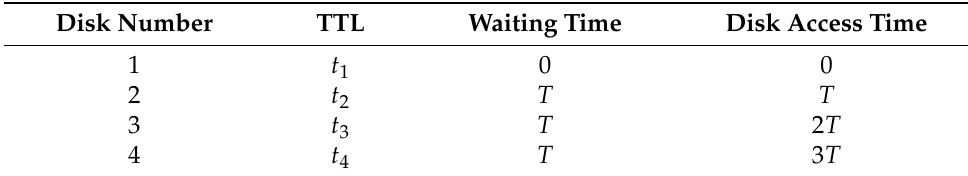
Table 3. Disk Access